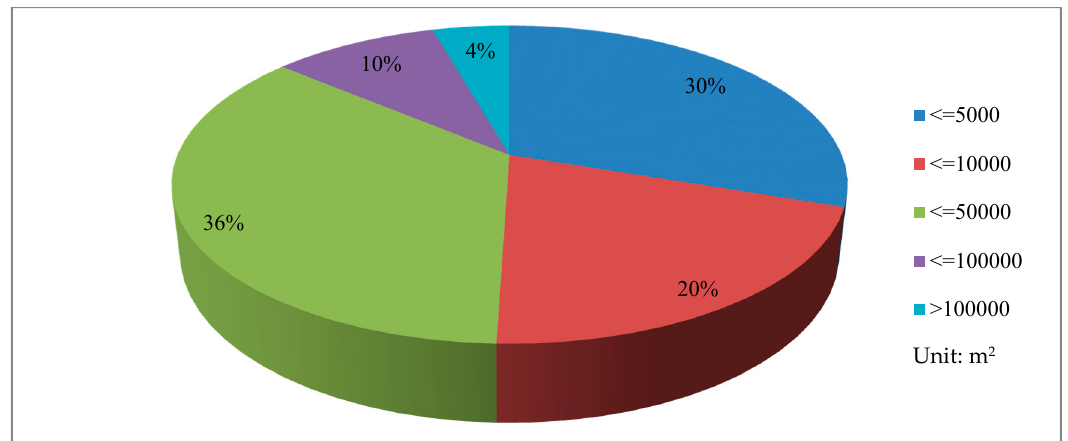
Figure 4. The frequency distribution of 295 slides.